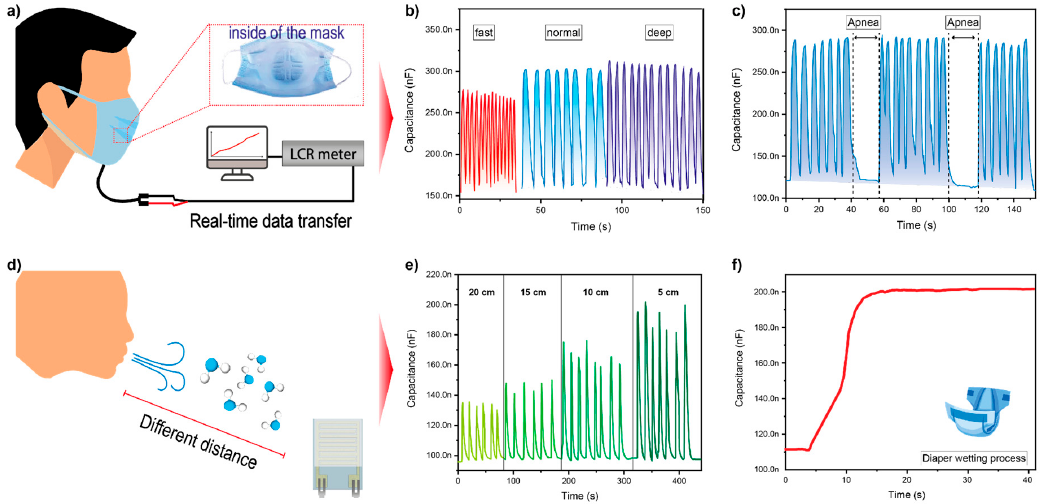
Figure 5. Real-time monitoring of the GO-doped P(VDF-TrFE)/LiCl-composite-based humidity sensor. ( a ) Schematic illustration of the experimental setup of the human respiratory monitoring. ( b ) The capacitance changes of the GO-doped P(VDF-TrFE)/LiCl-composite-based humidity sensor to deep, normal, and fast breathing. ( c ) The result of apnea and normal breathing processes. ( d ) An image of the respiration monitoring with several distances between sensors. ( e ) Capacitance variation of the distance between the sensor and the volunteer. ( f ) Diaper-wetting process. Table 2. Humidity performance of the GO-doped P(VDF-TrFE)/LiCl-composite sensor compared with that of sensors from previous studies.